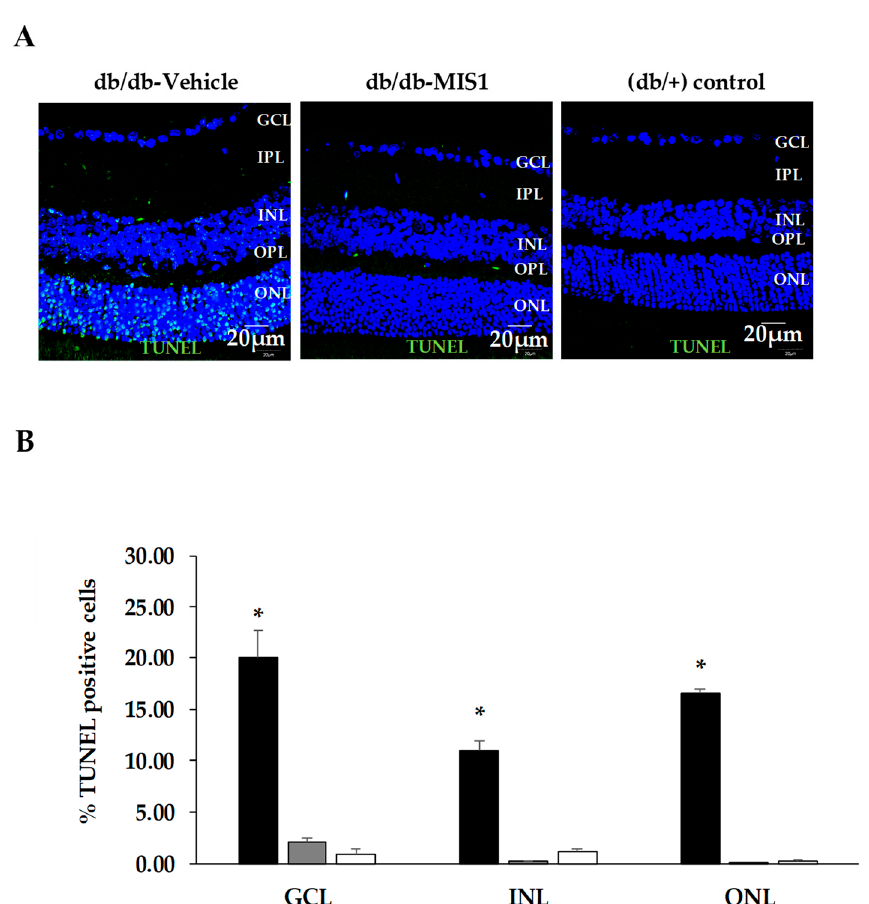
Figure 3. Effect of topical (eye drops) SOCS1 peptidomimetic (MIS1) administration on apoptosis. ( A ) TUNEL positive immunofluorescence (green) in a representative mouse from each group. Scale bars, 20 µm. ( B ) Percentage of TUNEL positive cells in the neuroretina. Nuclei were labeled with Hoechst (blue). ONL: outer nuclear layer; INL: inner nuclear layer; GCL: ganglion cell layer. Black columns: db/db-vehicle; Gray columns: db/db-MIS1; White columns: db/+. Results are mean ± SD. *: p < 0.01 in comparison with the other groups. N: 7 mice per group.